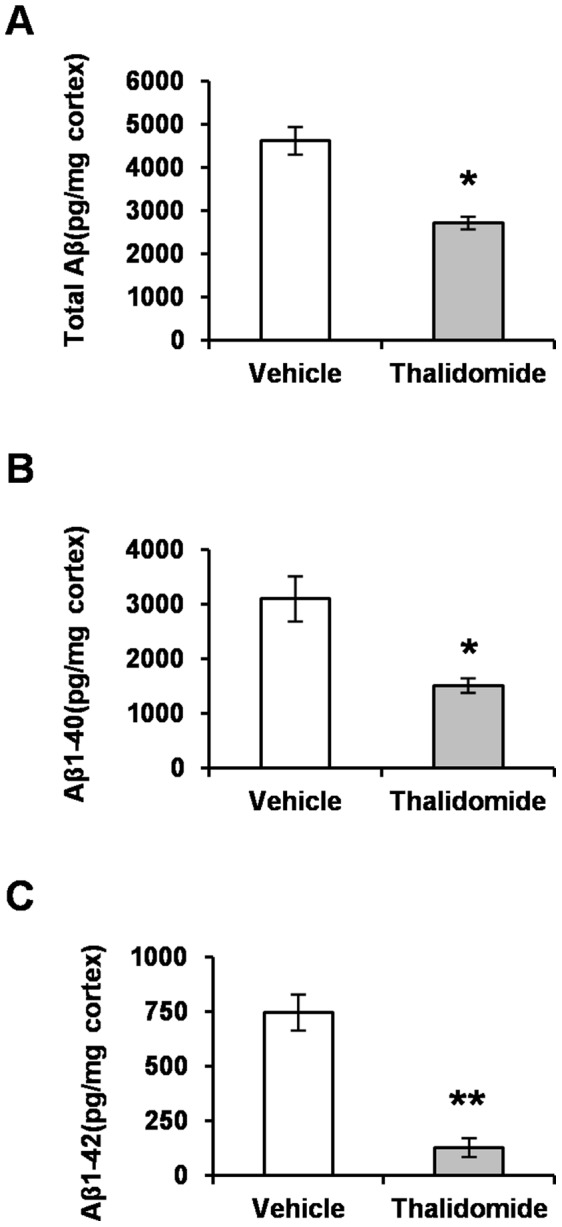
Thalidomide reduces Aβ load.ELISA analysis revealed a decrease in the amount of total Aβ (A), insoluble Aβ1–40 (B) and Aβ1–42 (C), which was calculated as picogram per milligram of protein in the neocortex of APP23 mice exposed 100 mg/kg of thalidomide for 3 months (Mean ± SD, *p<0.05, **p<0.01, Students t-test, n = 10 each group).